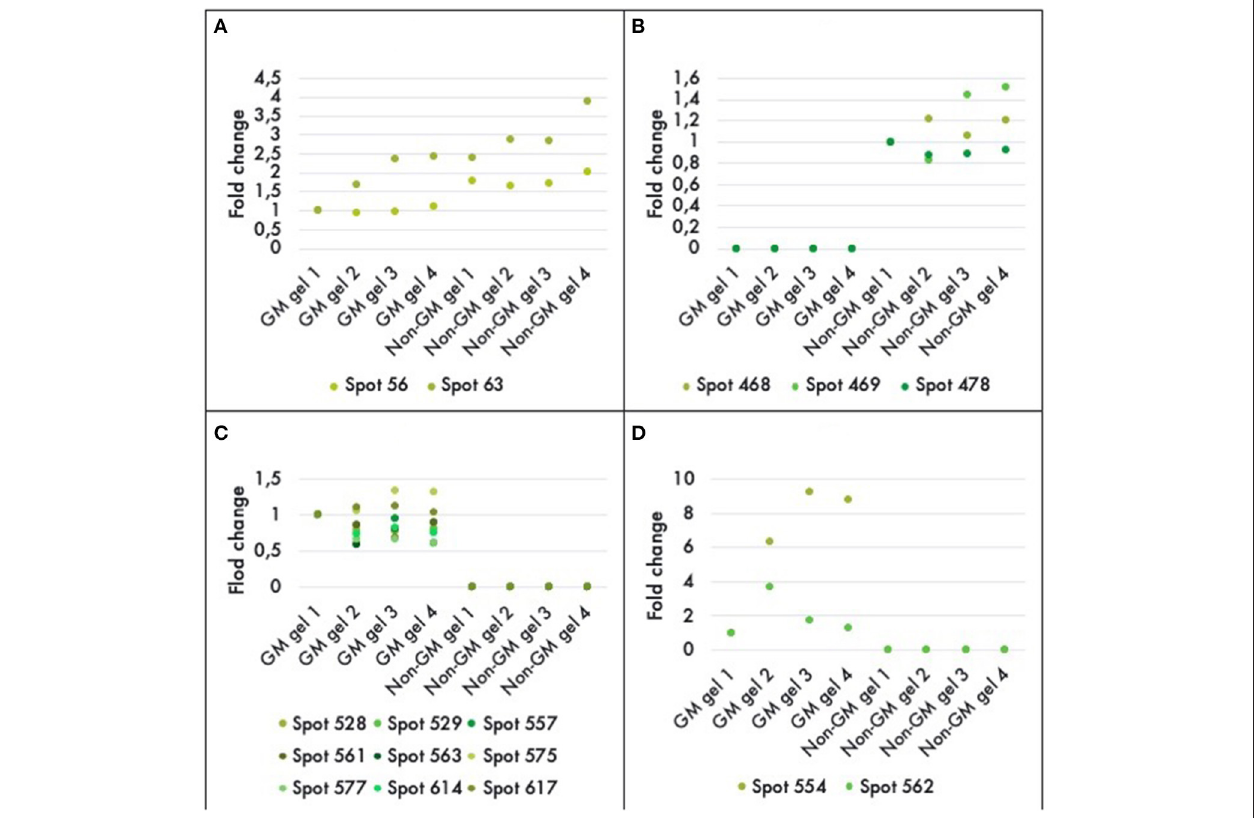
FIGURE 4 | Histograms of fold-differences of proteins found to be significantly different (ANOVA, P < 0.05) in leaf samples of genetically modified maize (MON810 event) and non-transgenic near isogenic (PAN 6Q-121) field-grown in Bloemfontein (South Africa; autumn 2009). Sixteen proteins out of an average of 765 spots presented a significant difference in abundance; in which two were down regulated (A) , three were repressed (B) , and 11 were only expressed in the GM plants (C,D) . Spots 554 and 562 had greater values and were, therefore, included in a new histogram. Protein expression levels represent the relative protein expression compared to a reference gel (four technical replicates were